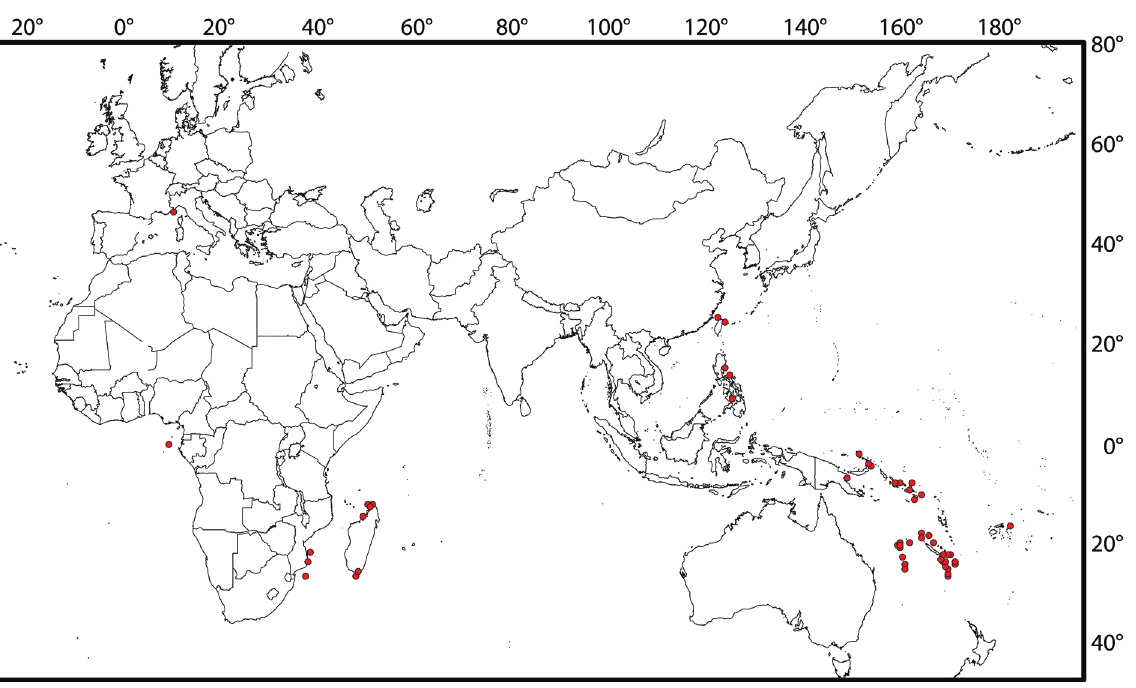
Fig. 1. Map showing sampling localities. See Supplementary file for